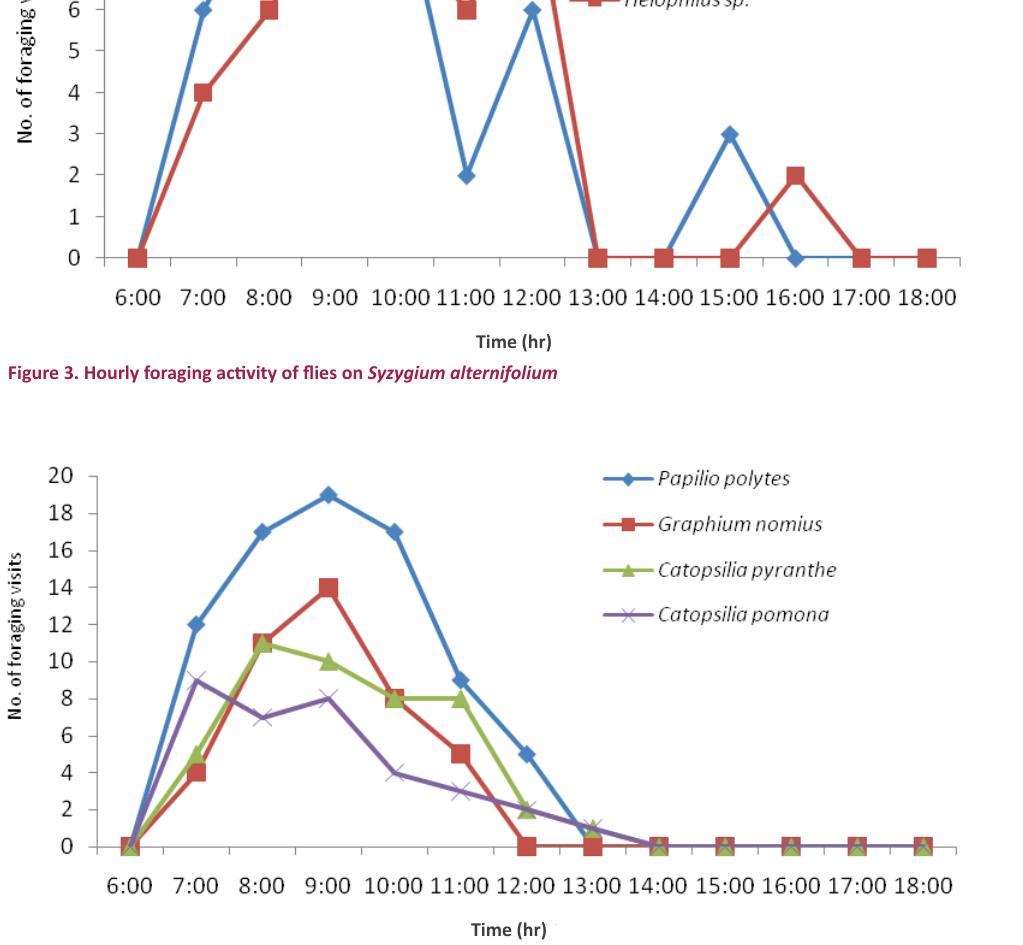
Figure 4. Hourly foraging activity of Papilionid and Pierid butterflies on Syzygium